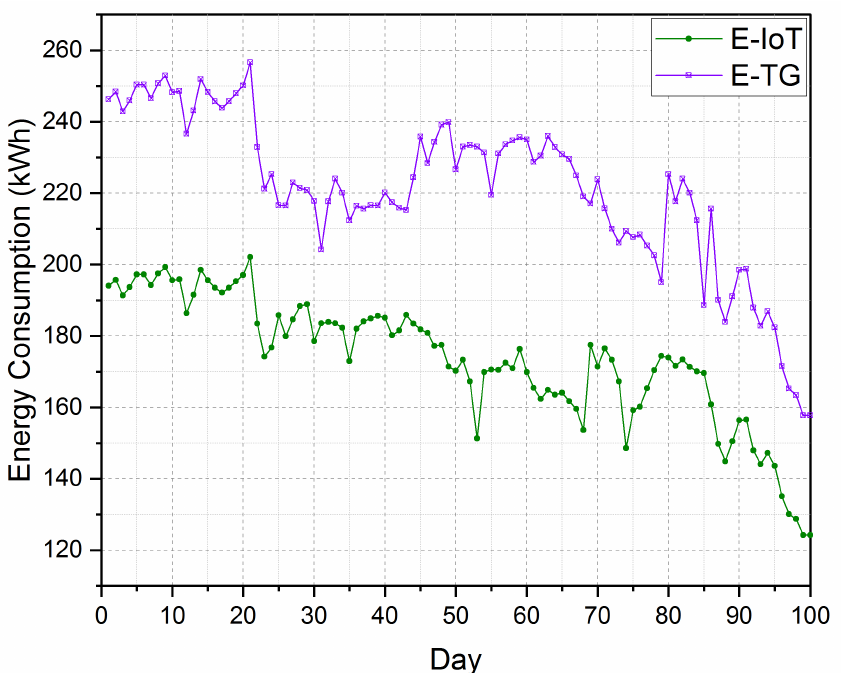
Figure 17. The electrical energy consumption (kWh/day) of the greenhouse with the established platform (E-IoT) against the same greenhouse under identical circumstances (E-TG).